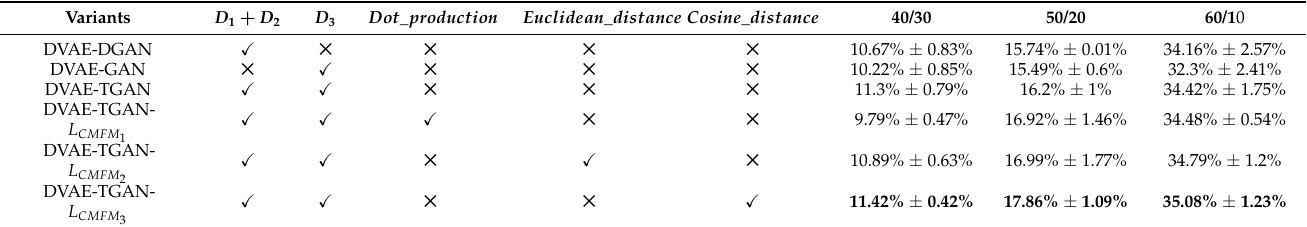
Table 2. Ablation